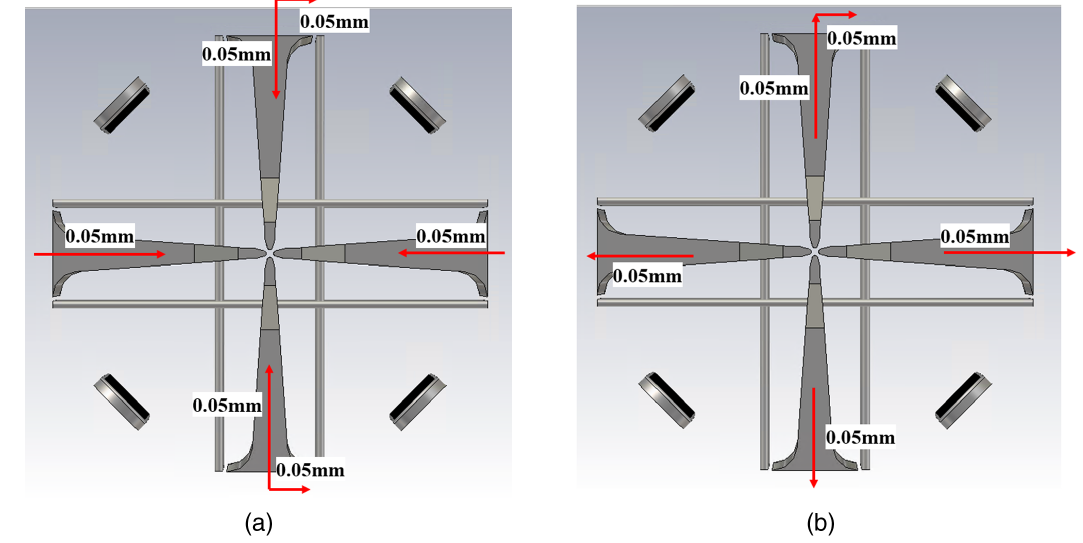
FIG. 11. Two cases of vanes misalignment: (a) Vanes were moving inward; (b) Vanes were moving outward. Arrows denoted the vanes moving